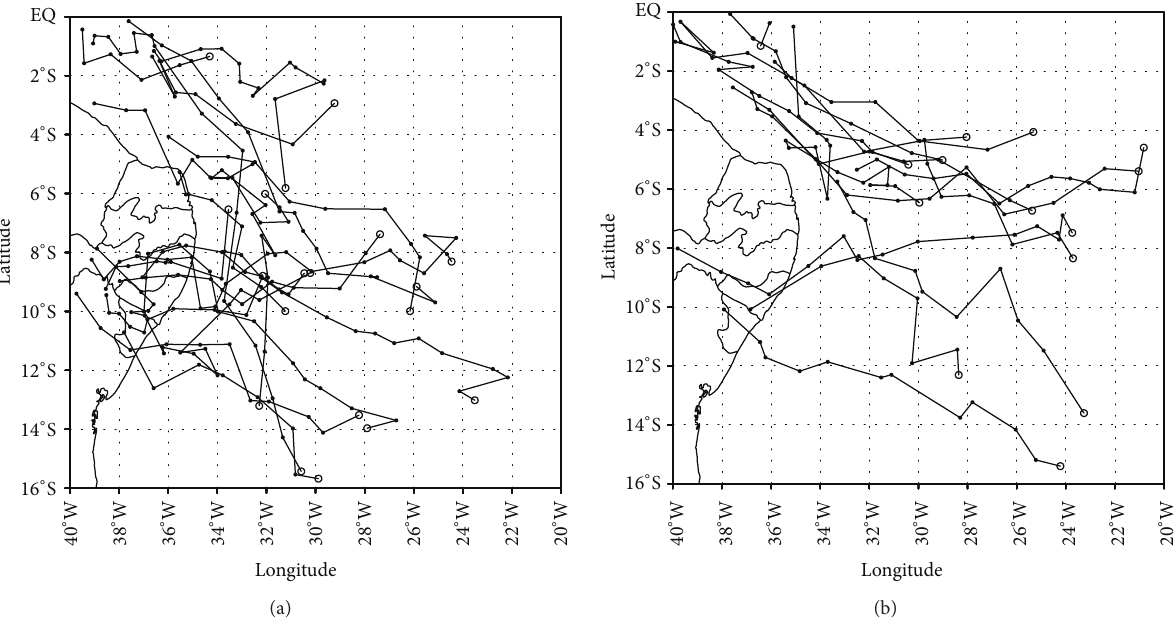
Figure 10: Cyclonic vorticity centres tracks for April–July 2006 (a) and 2007 (b) at 850